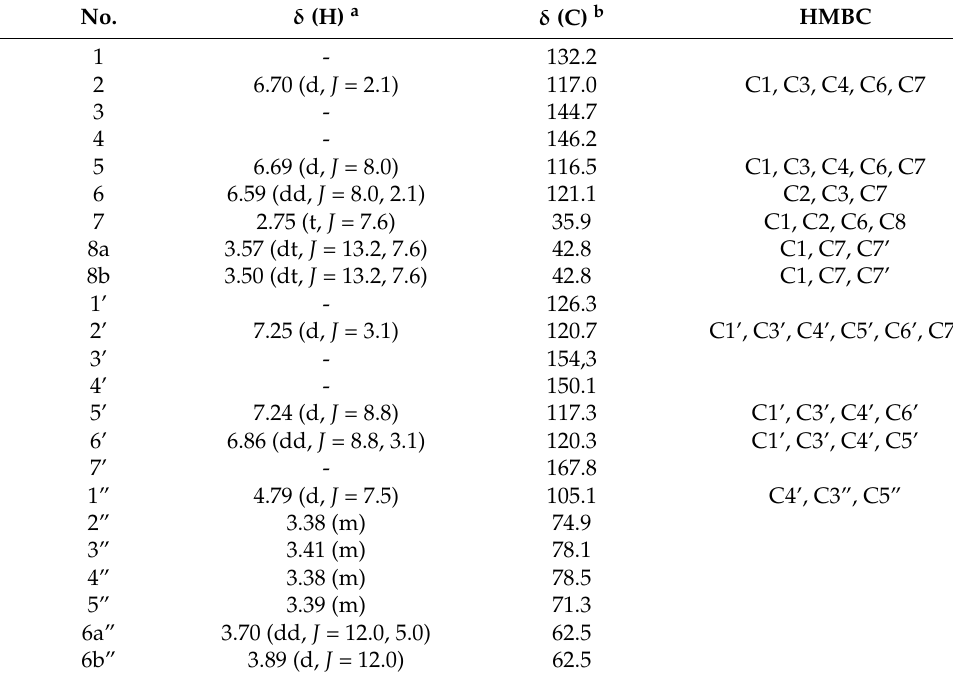
Figure 3. Key 1 H- 1 H COSY, HMBC, and ROESY correlation of 2 . Table 2. 1 H- and 13 C-NMR data of 2 (in CD 3 OD; δ in ppm, J in Hz).